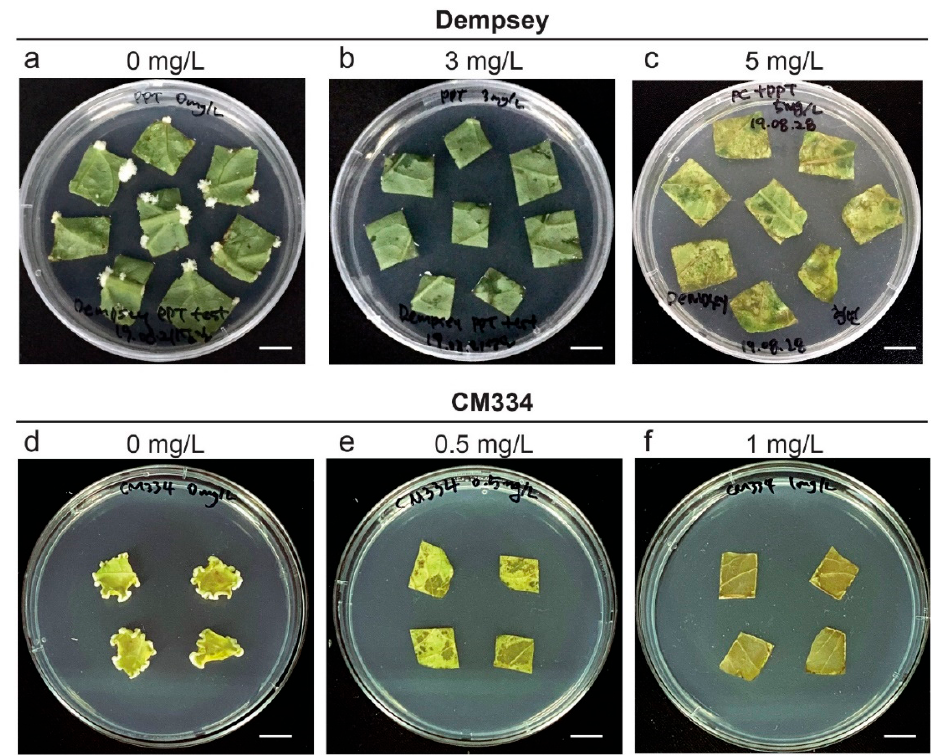
Figure 3. Effects of PPT on selection of callus of explants transformed by three different strains of Agrobacterium . ( a–c ) Examination of a suitable concentration of PPT for cv. Dempsey leaf explants. Cultivar Dempsey leaf explants were placed on CIM without PPT (0 mg/mL) ( a ), and with PPT at 3 mg/L ( b ) and 5 mg/L ( c ); ( d–f ) Examination of a suitable concentration of PPT for cv. CM334 leaf explants. Cultivar CM334 leaf explants on CIM without PPT (0 mg/mL) ( d ), and with PPT at 0.5 mg/L ( e ) and 1 mg/L ( f ) are shown. All explants on the indicated PPT medium were examined for 10 days. Scale bars = 1 cm. PPT, phosphinothricin; CIM, callus induction medium.